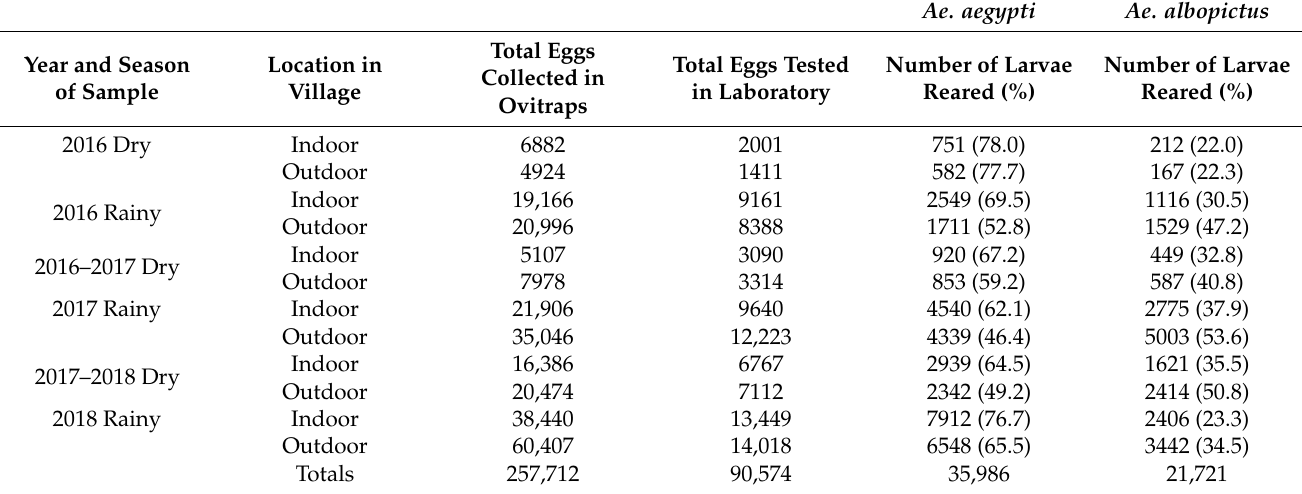
Table 2. Total number of Aedes spp. eggs collected from indoor and outdoor ovitraps in Hidalgo village, number of eggs used for laboratory hatching and rearing studies, and prevalence of Ae. aegypti and Ae. albopictus determined by laboratory rearing from January 2016 to November 2018.